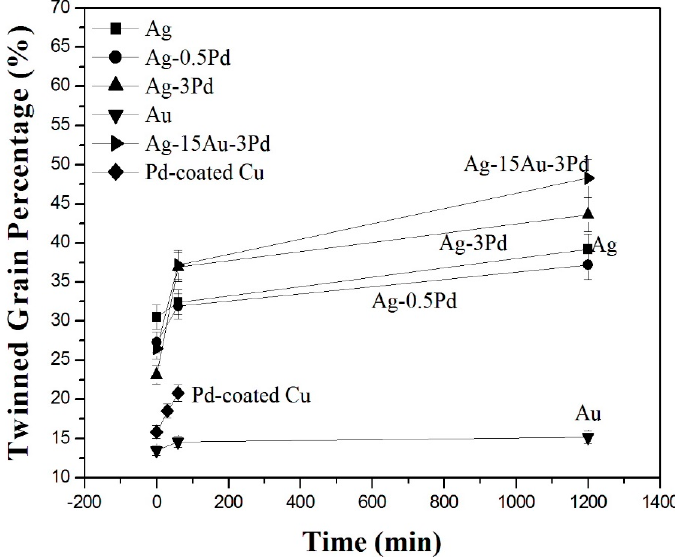
Figure 10. Percentages of annealing twins in all bonding wires in this study after current stressing at 1.23 × 10 5 A/cm 2 for various times.